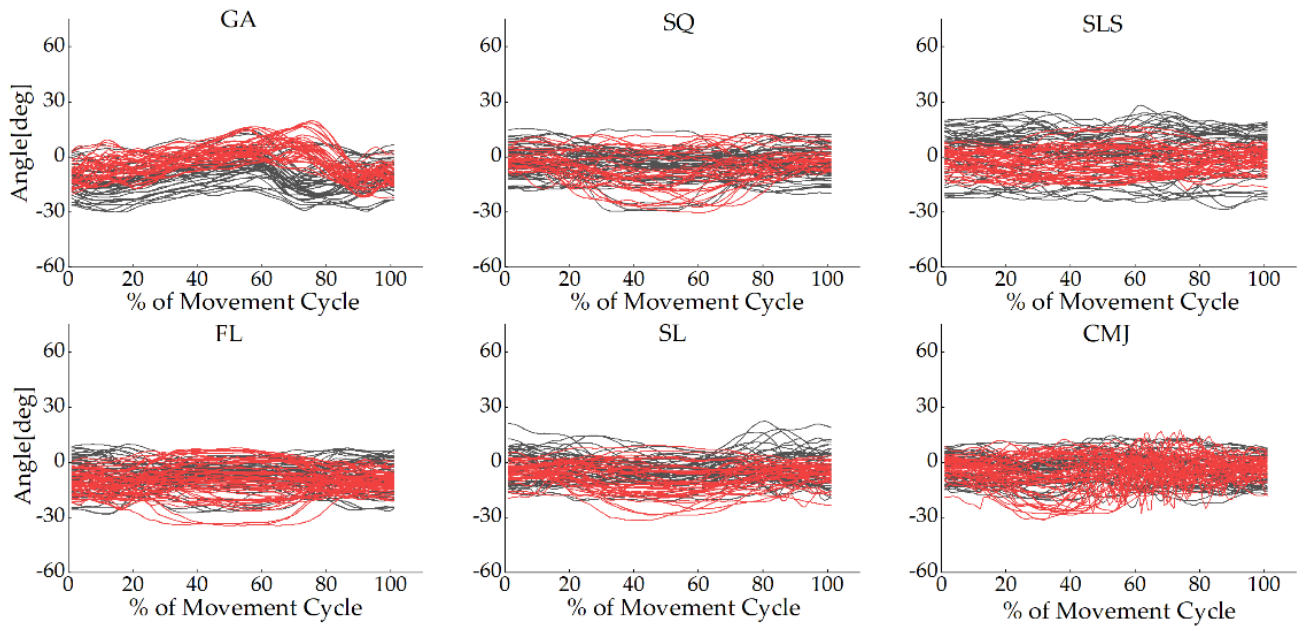
Figure A4. Knee joint angles in the transverse plane for each participant in all tasks during the movement cycle of the gait (GA), squat (SQ), single-leg squat (SLS), side lunge (SL), forward lunge (FL), and counter-movement jump (CMJ). The black lines represent the OptiTrack system, while the red lines represent the Perception Neuron ® system. The Y -axis depicts joint angles in degrees, while the X -axis depicts the movement cycle in %.